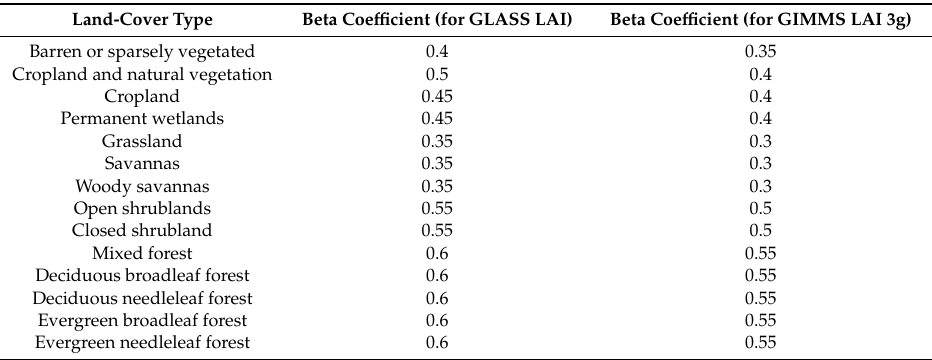
Figure 3. Locations of reference sites. Table 3. Beta coe ffi cient in resilience